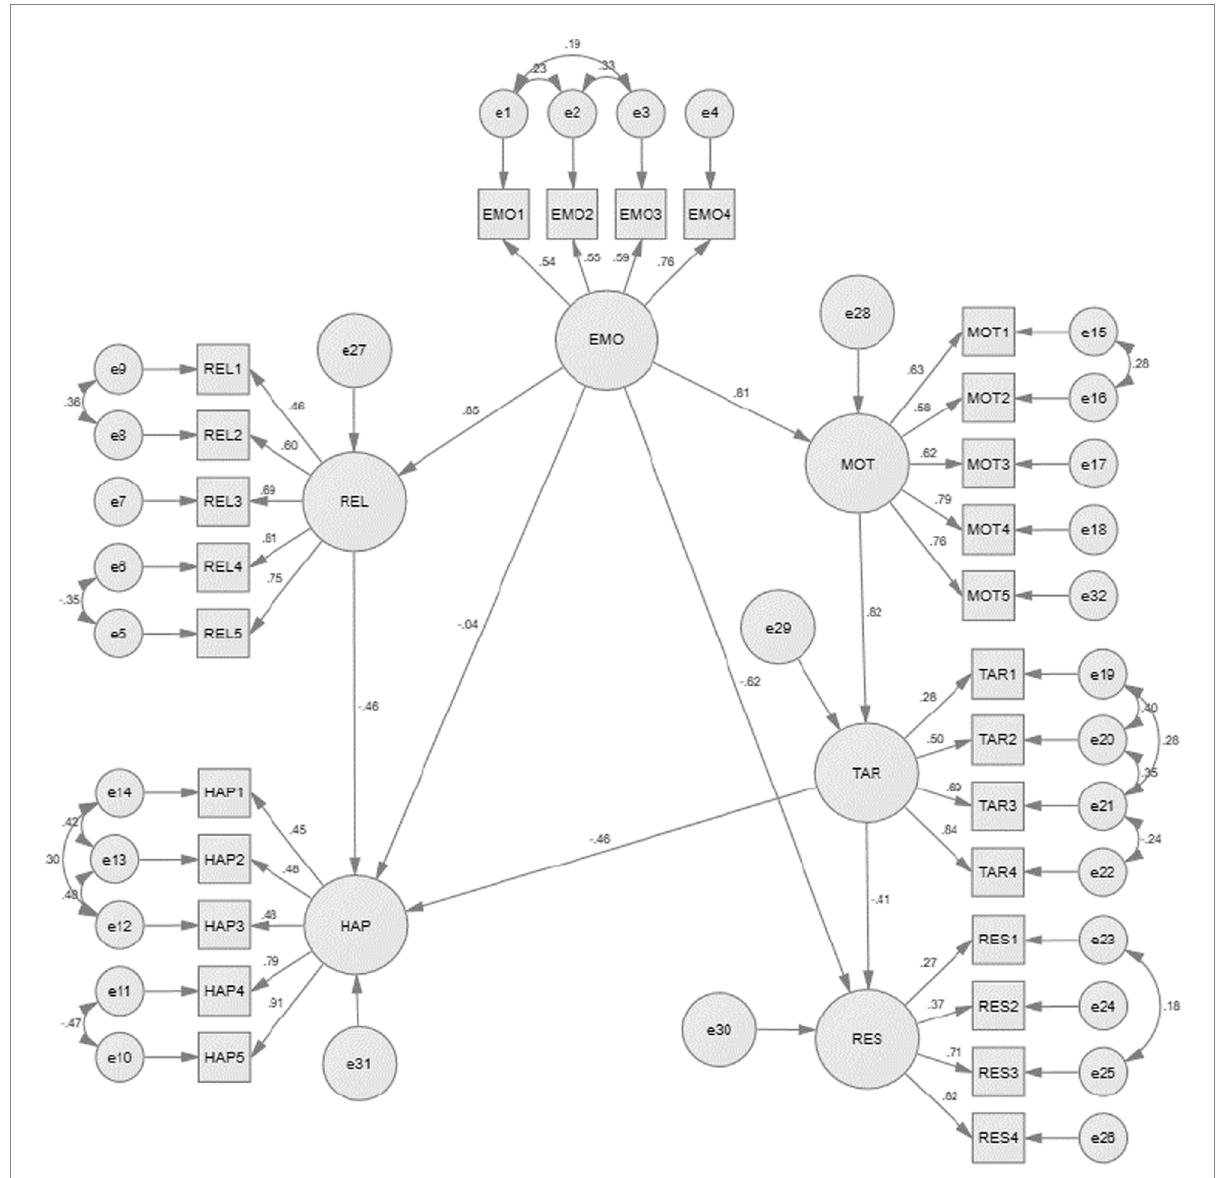
FIGURE 3 The revised structural equation